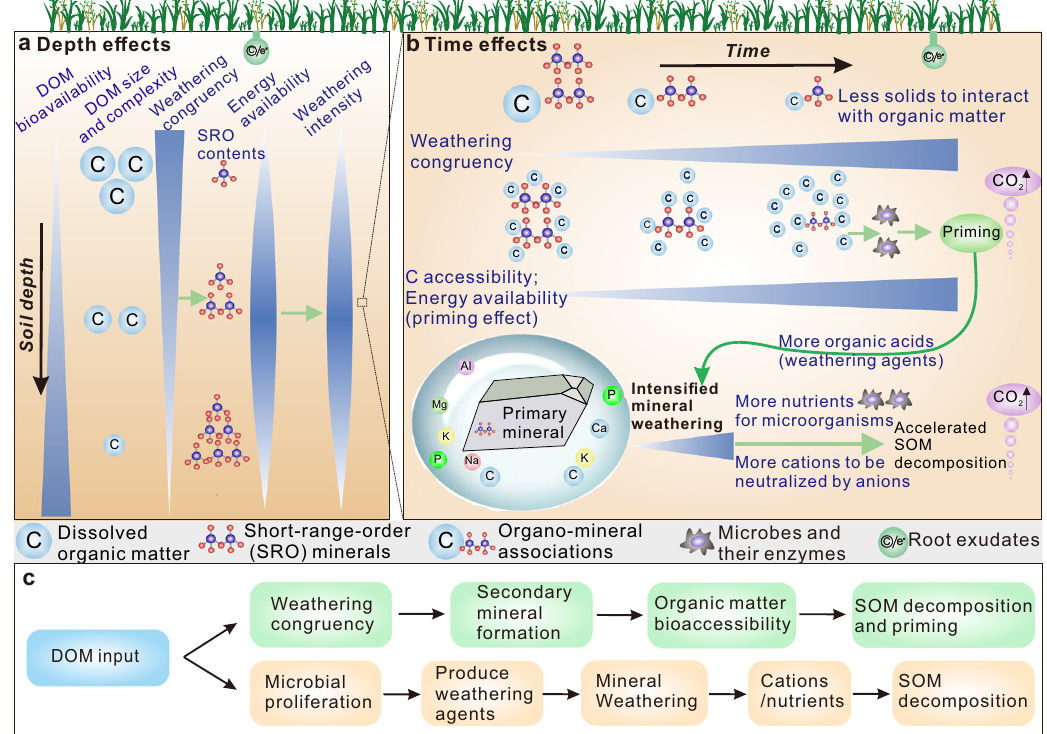
Fig. 7 | Proposed mechanisms for the priming effect and its linkage to mineral weathering. a Depth effect: Mechanisms for linkage between mineral weathering and primed soil organic matter (SOM) decomposition, which is dependent on decreasing dissolved organic matter (DOM) molecular size and complexity and increasing DOM bioavailability with depth. Mineral weathering congruency diminishes with depth because of decreasing DOMmolecularsizeand complexity. The fl uxandbioavailabilityofDOMjointlyresultinadecreaseofenergyavailability with depth, which partly explains vertical changes in weathering intensity (SRO: short-range-order minerals). b Time effect: At the temporal scale, weathering congruency generally increases with diminishing DOM molecular size and